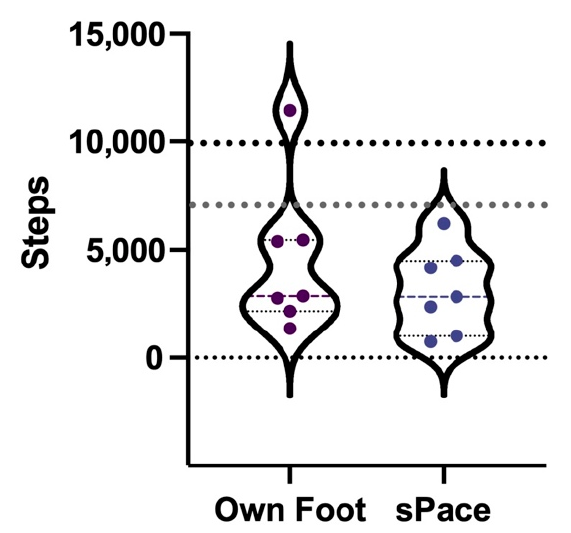
Figure 6. Average daily steps of participants wearing their own or sPace prosthetic foot ( n = 7). Note: violin plots show distribution of data, dark dashed line indicates mean, lighter dotted lines indicate upper and lower quartiles, and gray and black horizontal dots indicate recommended daily step count ranges of 7000–10,000 steps.